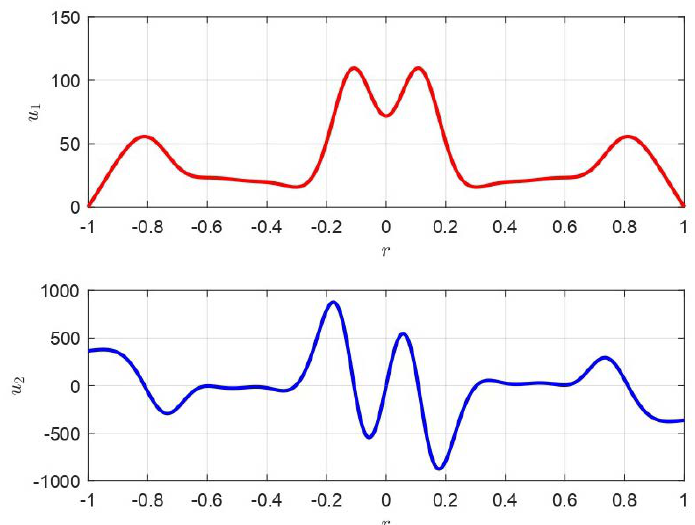
Figure 3. Recovering of the membrane by using the bvp4c MatLab R (cid:13) solver: θλ 2 = 0.5, 2.447 ≤ u 1 ≤ 2.453, u 2 =